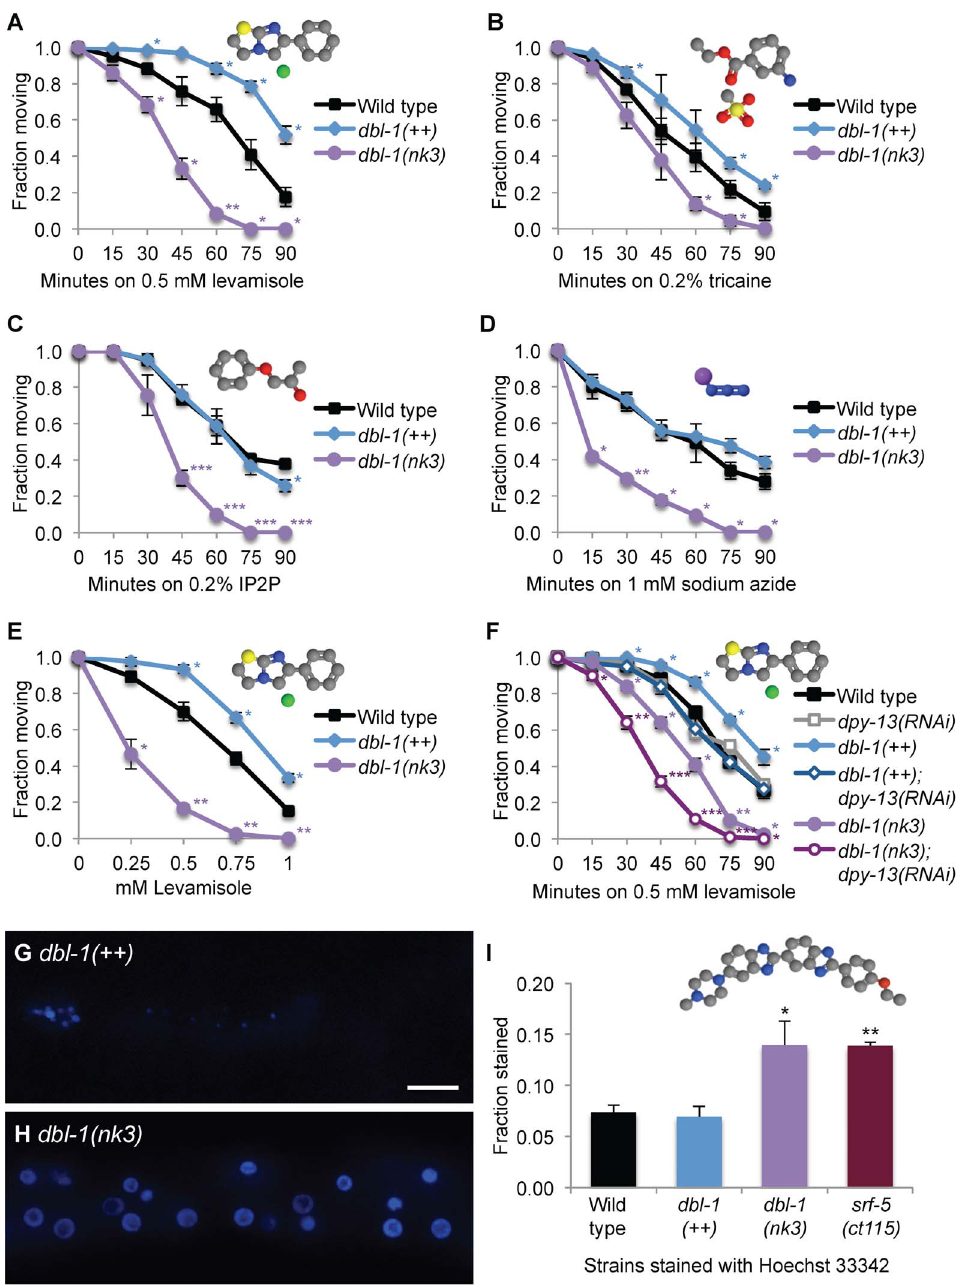
Figure 2. DBL-1 regulates cuticular permeability. (A-D) Sensitivity to levamisole (A), tricaine (B), IP2P (C), and sodium azide (D) was measured over time in animals with wild-type, increased ( dbl-1( ++ ) ), and reduced ( dbl-1(nk3) ) DBL-1 pathway signaling. (E) Sensitivity to different levamisole doses by animals with wild-type, reduced ( dbl-1(nk3) ), and increased ( dbl-1( ++ ) ) DBL-1 pathway signaling. (F) Sensitivity to levamisole in animals with different DBL-1 levels treated with C06C3.5 (pseudogene control) or dpy-13 RNAi was measured over time. (G–I) Hoechst 33342 staining in dbl-1( ++ ) (G) or dbl-1(nk3) (H) animals. Faint intestinal autofluorescence is visible in (G). Scale bar=10 m m. The fraction of animals that stain with Hoechst 33342 is shown in (I). Error bars indicate the mean 6 SEM. P-values compare data to wild type (***P # 0.0001; **P # 0.001; *P # 0.05) using the unpaired t-test. Chemical structures were drawn using Jmol: an open-source Java viewer for chemical structures in 3D. http://www.jmol.org/. Molecule key: gray, carbon; blue, nitrogen; purple, sodium; green, chloride; yellow, sulfur; and red, oxygen. rather than the hypodermal cell barrier. While DPY-13 affects cross-linkages within the cuticle, the enhanced sensitivity of dbl- 1( ++ ) or dbl-1 mutant animals with reduced DPY-13 levels suggests that DBL-1 and DPY-13 act on different aspects of the